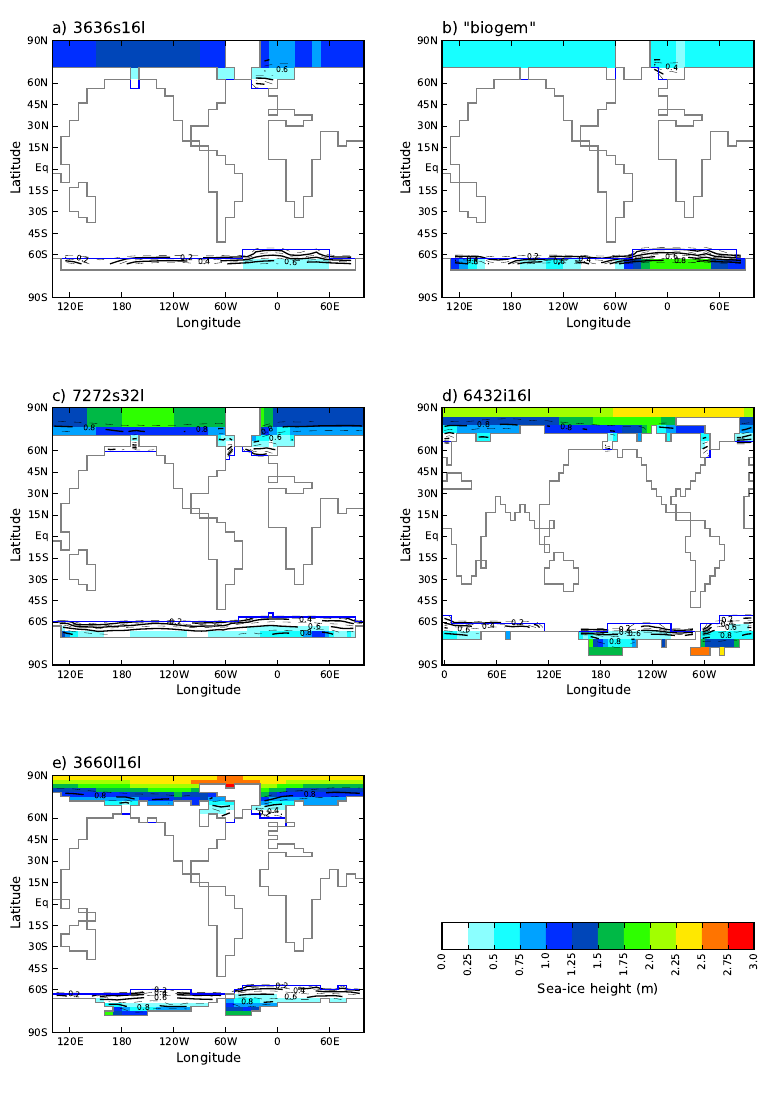
Fig. 15. Annual-mean sea-ice height (colors) and concentration (contours, contour interval of 0.1) in the five experiments. The blue lines denote the maximum extent of sea ice